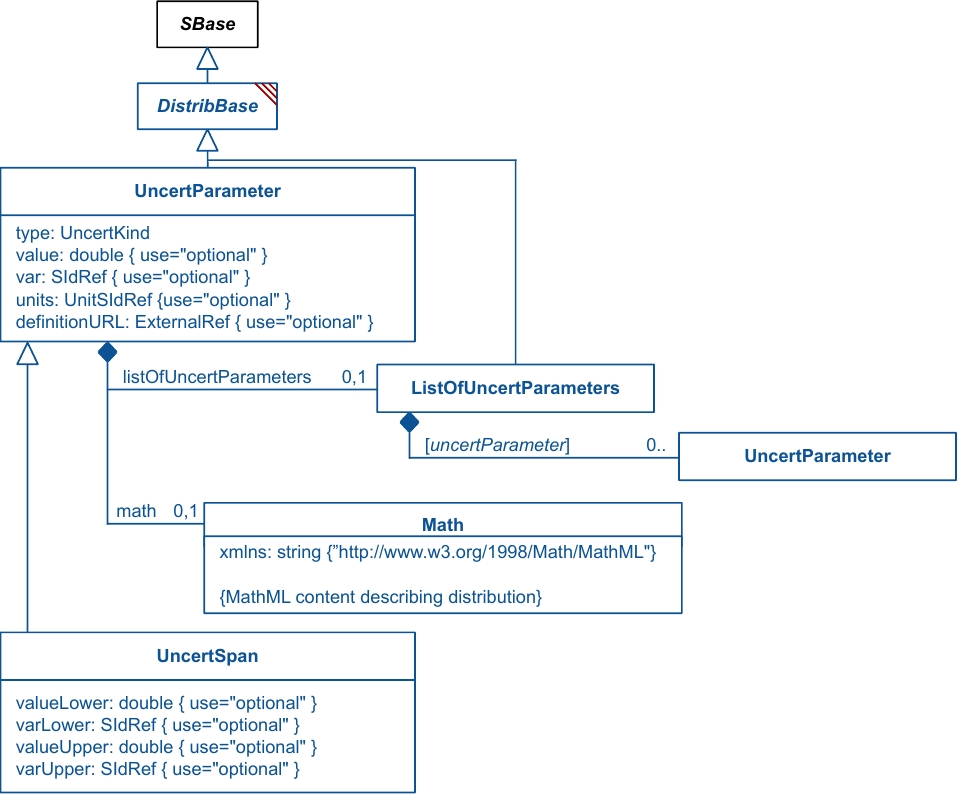
Figure 3: The definition of the UncertParameter , UncertSpan , and ListOfUncertParameters classes. These classes allow an Uncertainty to define an uncertainty